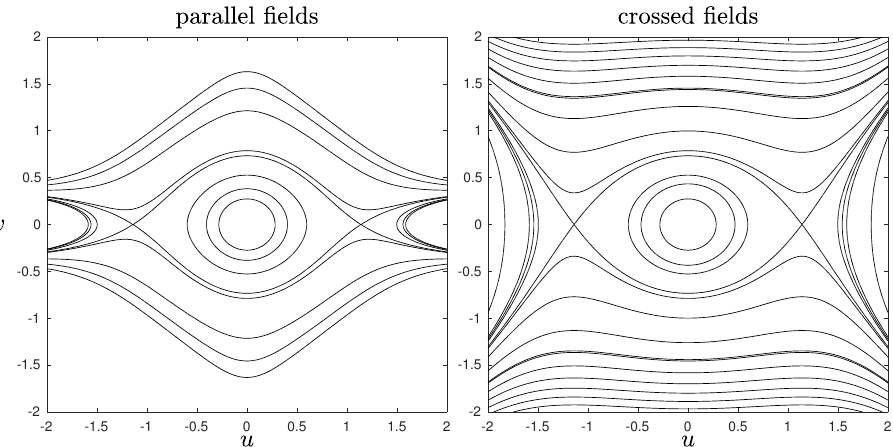
Figure 5. Left figure shows the potential for the parallel fields case, and the right figure shows the potential for the crossed fields case. ( E =